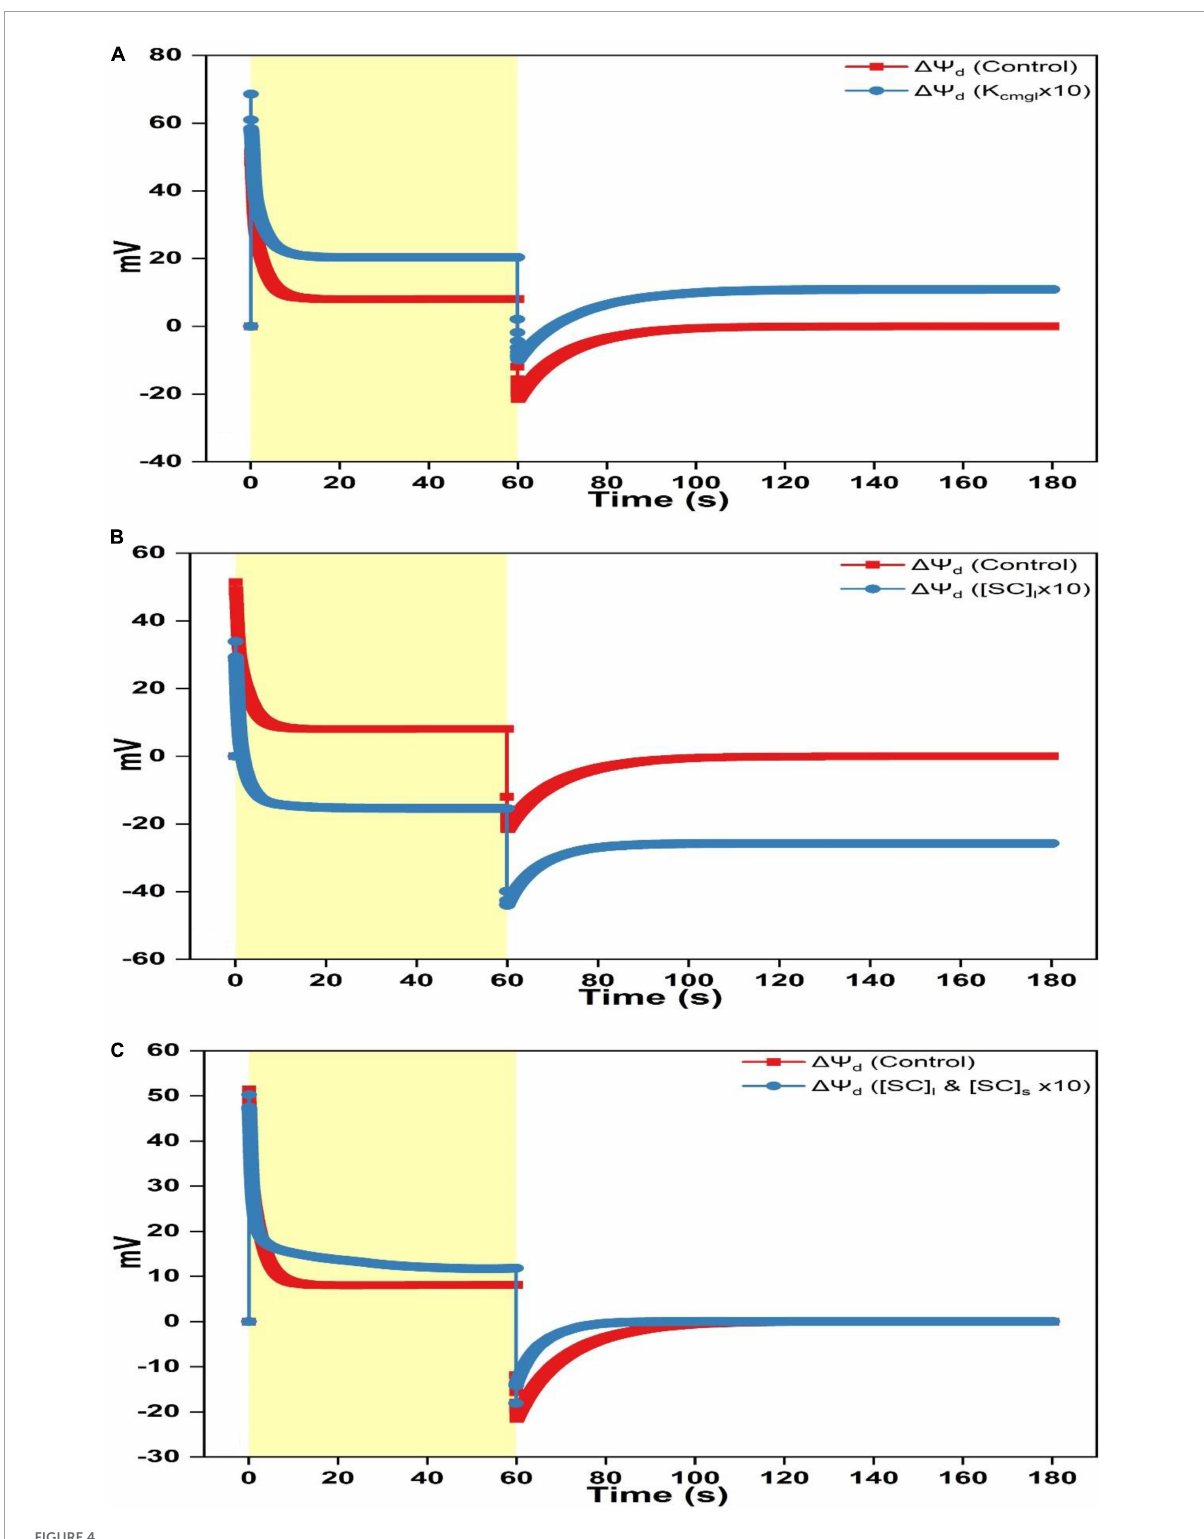
FIGURE4 Simulated responses of (cid:49)(cid:57) d on assigning different values for adjustable parameters. (A) Simulated responses of (cid:49)(cid:57) d by adjusting K cmgl 1- and 10-fold of the controlled value. (B) Simulated responses of (cid:49)(cid:57) d by adjusting [SC] l 1- and 10-fold of the controlled value. (C) Simulated responses of (cid:49)(cid:57) d by adjusting [SC] l and [SC] s 1- and 10-fold of the controlled